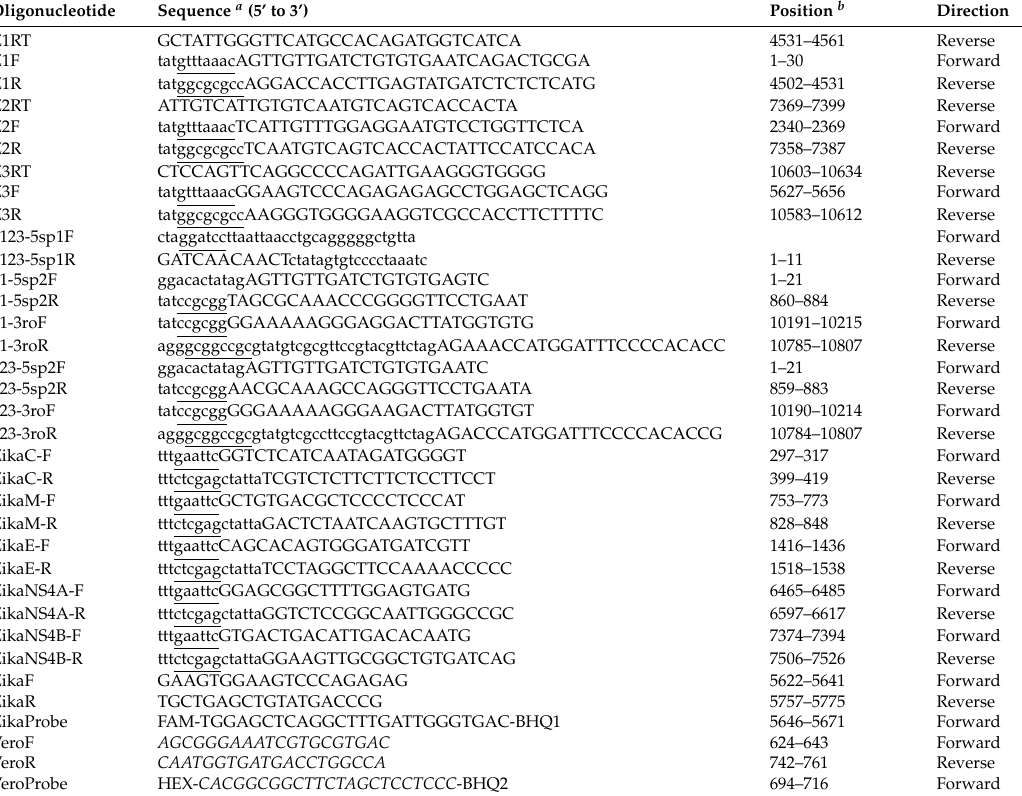
Table 2. Oligonucleotides used in this